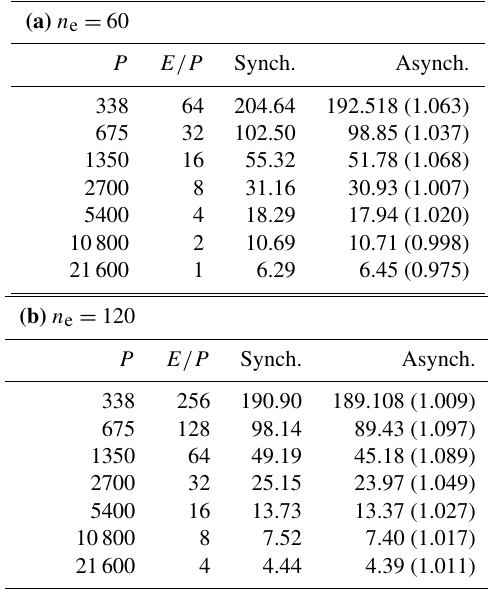
Table 1. Results for the strong scaling of the SE method (np = 4 and nlev = 26) and for n e = 60 (a) and n e = 120 (b) . We list the number processes P, the maximum number of elements per process E/P , and the times for the synchronous and asynchronous communica- tion methods. The speedup of using asynchronous communication is included in